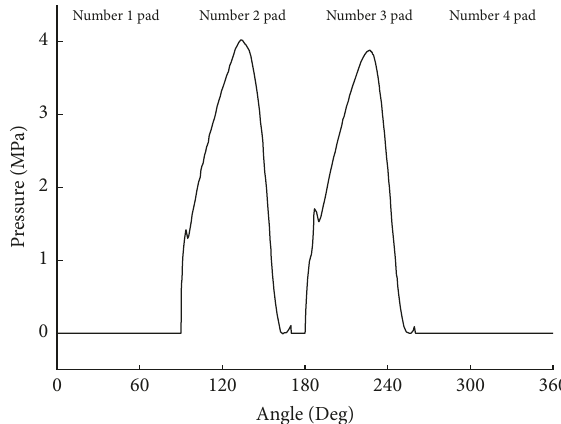
Figure 2: Experimental film pressure at 3000 r/min and under 180 kN loading [25].